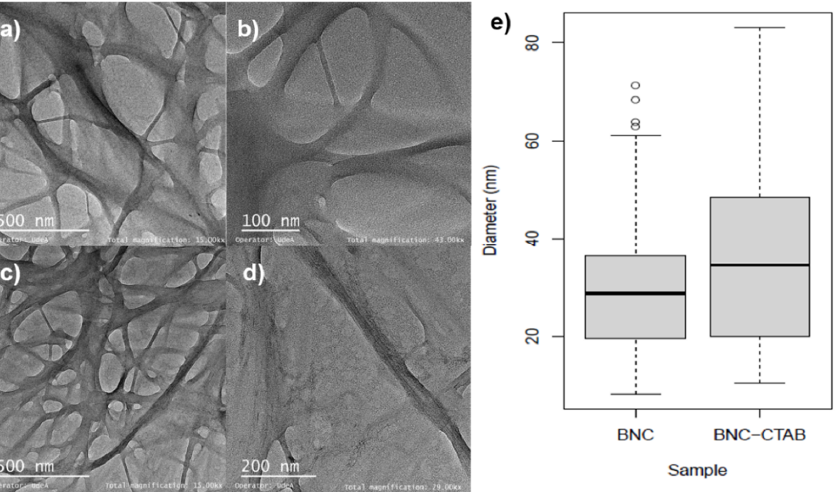
Figure 2. Morphological analysis ( a ) TEM micrographs of BNC at 15 kX; ( b ) TEM micrographs of BNC at 43 kX; ( c ) TEM micrographs of BNC-CTAB at 15 kX; ( d ) TEM micrographs of BNC-CTAB at 29 kX; ( e ) diameter distribution graphic.